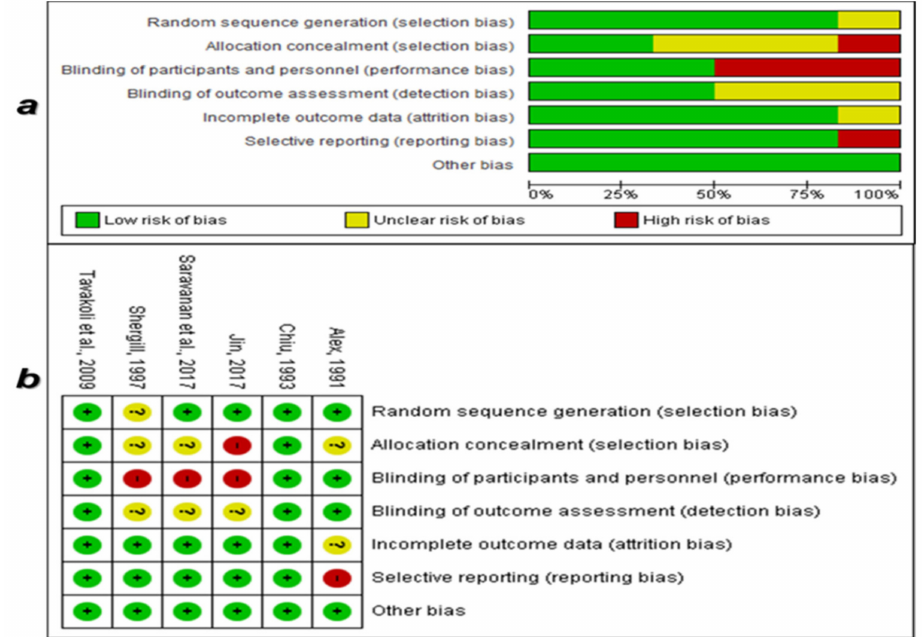
Figure 2. Quality assessment of the risk of bias in the randomized interventional studies. ( a ) Risk of bias across studies, ( b ) risk of bias within each study. Table 2. Quality assessment of the risk of bias in the non-randomized interventional studies (Quasi design). Balanced Study Causal Characteristics ID Relationships